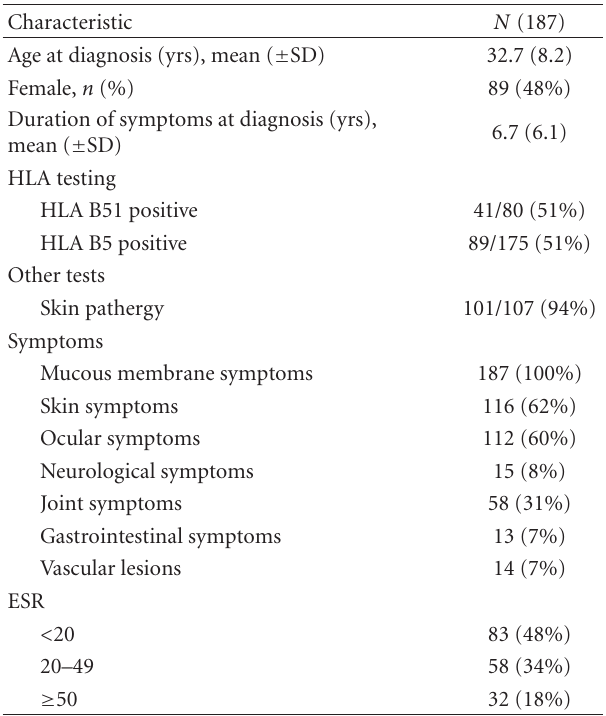
Table 1: Baseline characteristics of patients with Behc¸et’s Disease. Characteristic